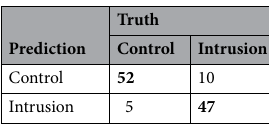
Table 1. Confusion matrix of the poacher detection algorithm. Bold numbers indicate correct